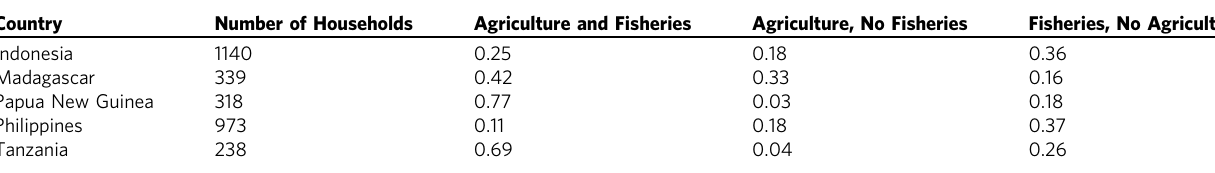
Table 1 Proportion of surveyed households in each study country engaged in both agriculture and fi sheries, agriculture but not fi sheries, and fi sheries but not agriculture.